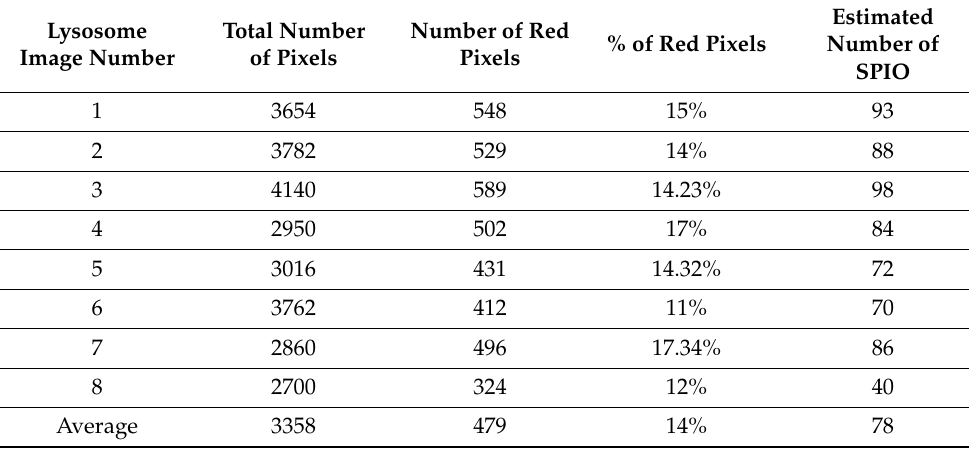
Table 1. The results of 8 images of lysosome/microvesicles where the percentage and the estimated number of SPIO-NPs is shown in the last 2 columns .